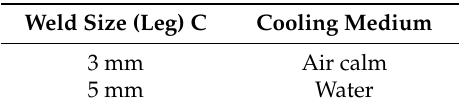
Table 2. Variables for manufacturing.